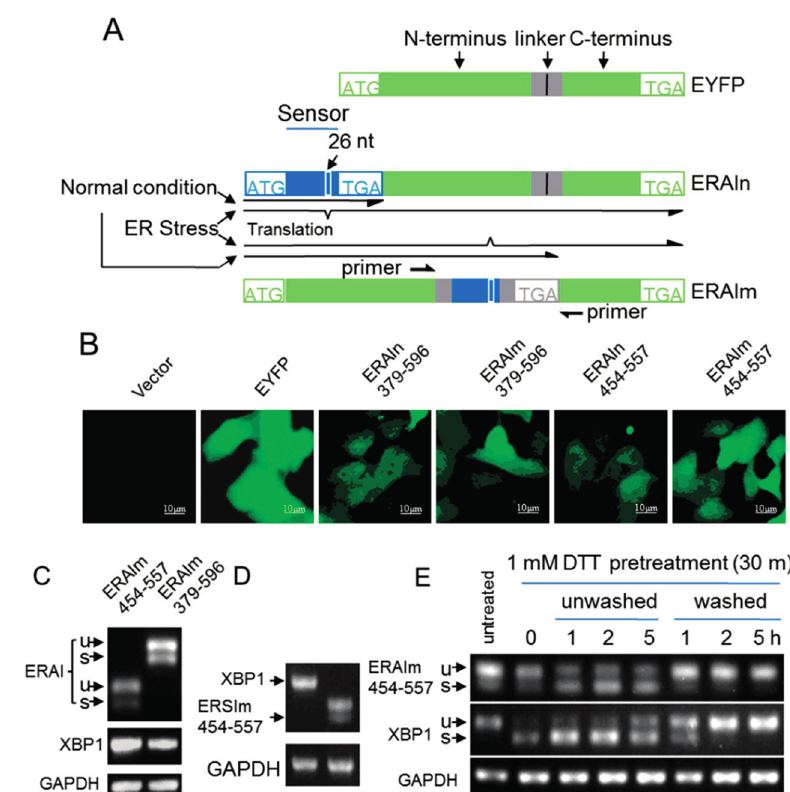
Figure 1. Acute ER (endoplasmic reticulum) stress-independent splicing of XBP1 mRNA sensor sequence. ( A ) Schematic representation of ER stress activation indicators